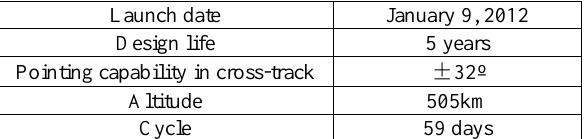
Table 1. Main characteristics of the ZY-3